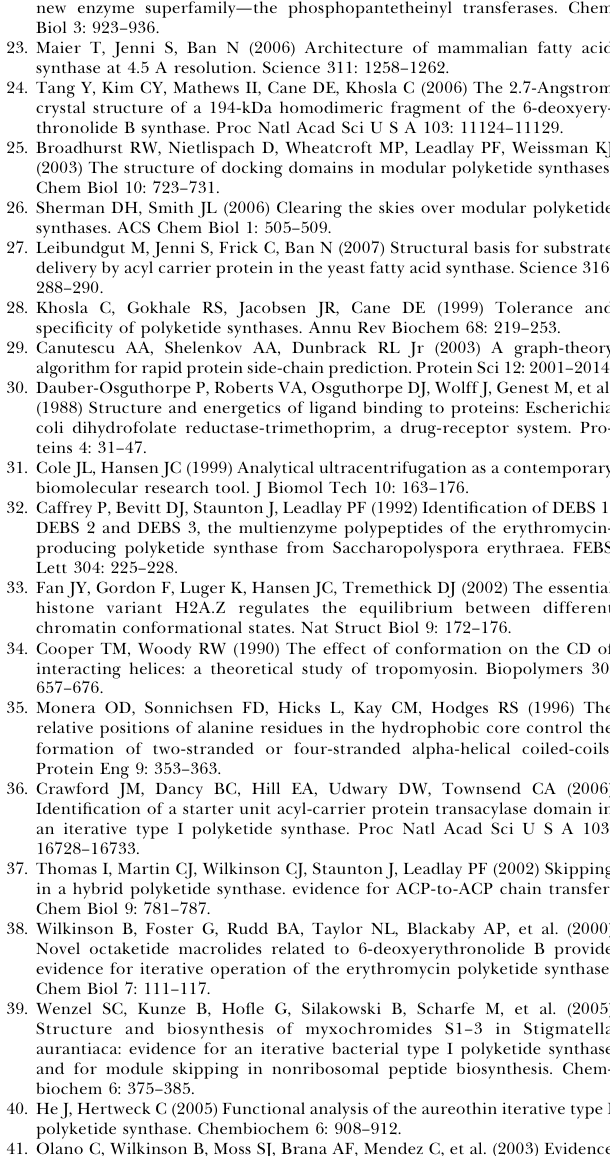
Figure S4. Analytical Ultracentrifugation Analysis of Linker-Change Mutant Analysis of linker-change mutant of PKS12 D 1 by sedimentation velocity in the XL1-analytical ultracentrifuge in 50 mM phosphate buffer (pH 7.2). The data were analyzed to yield the integral distribution of sedimentation coefficients. Found at doi:10.1371/journal.pbio.0060163.sg004 (13 KB PDF). Table S1. Highlighting Mutations for Site-Directed Mutagenesis of Key Residues Mutations are indicated in bold